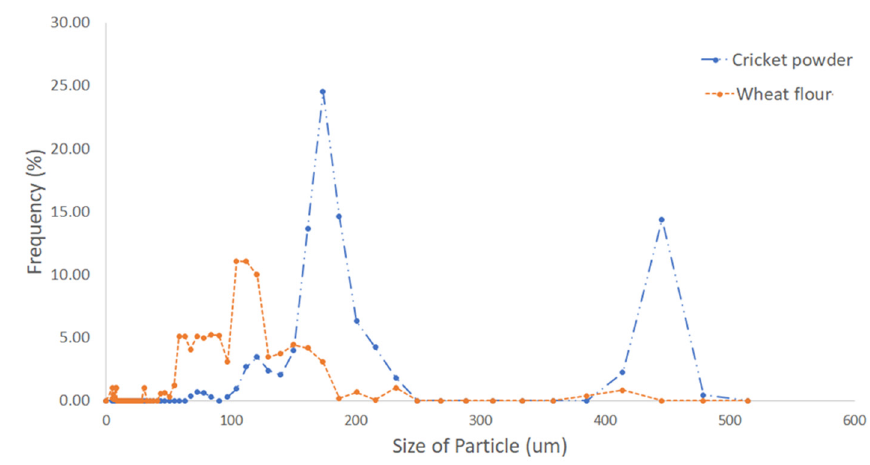
Figure 2. Particle size distribution of wheat flour and cricket powder.